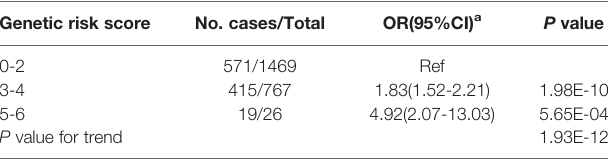
TABLE 2 | Associations between the m6A regulator SNPs cumulative risk score and T1D risk in a Chinese